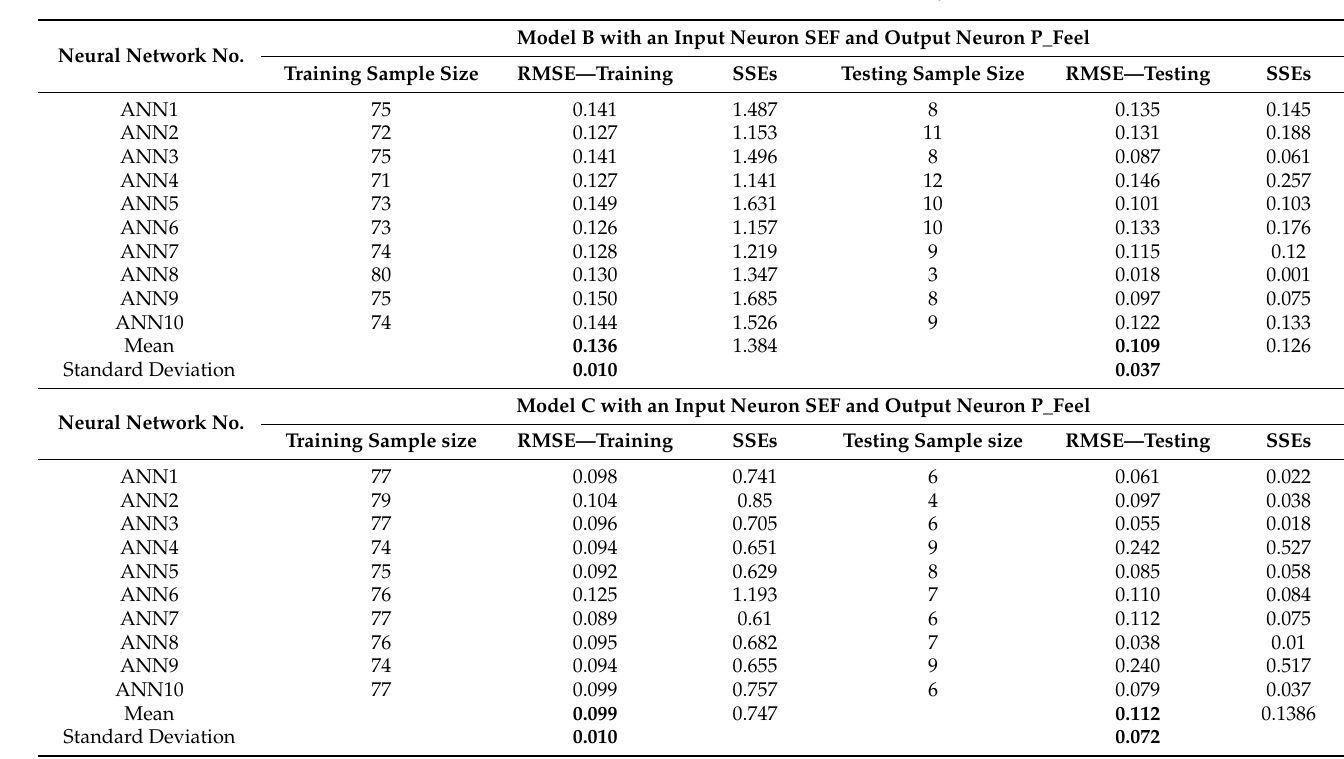
Figure 12. RMSE relationship between training and testing in Model A. Table 12. Model B and Model C Predictive